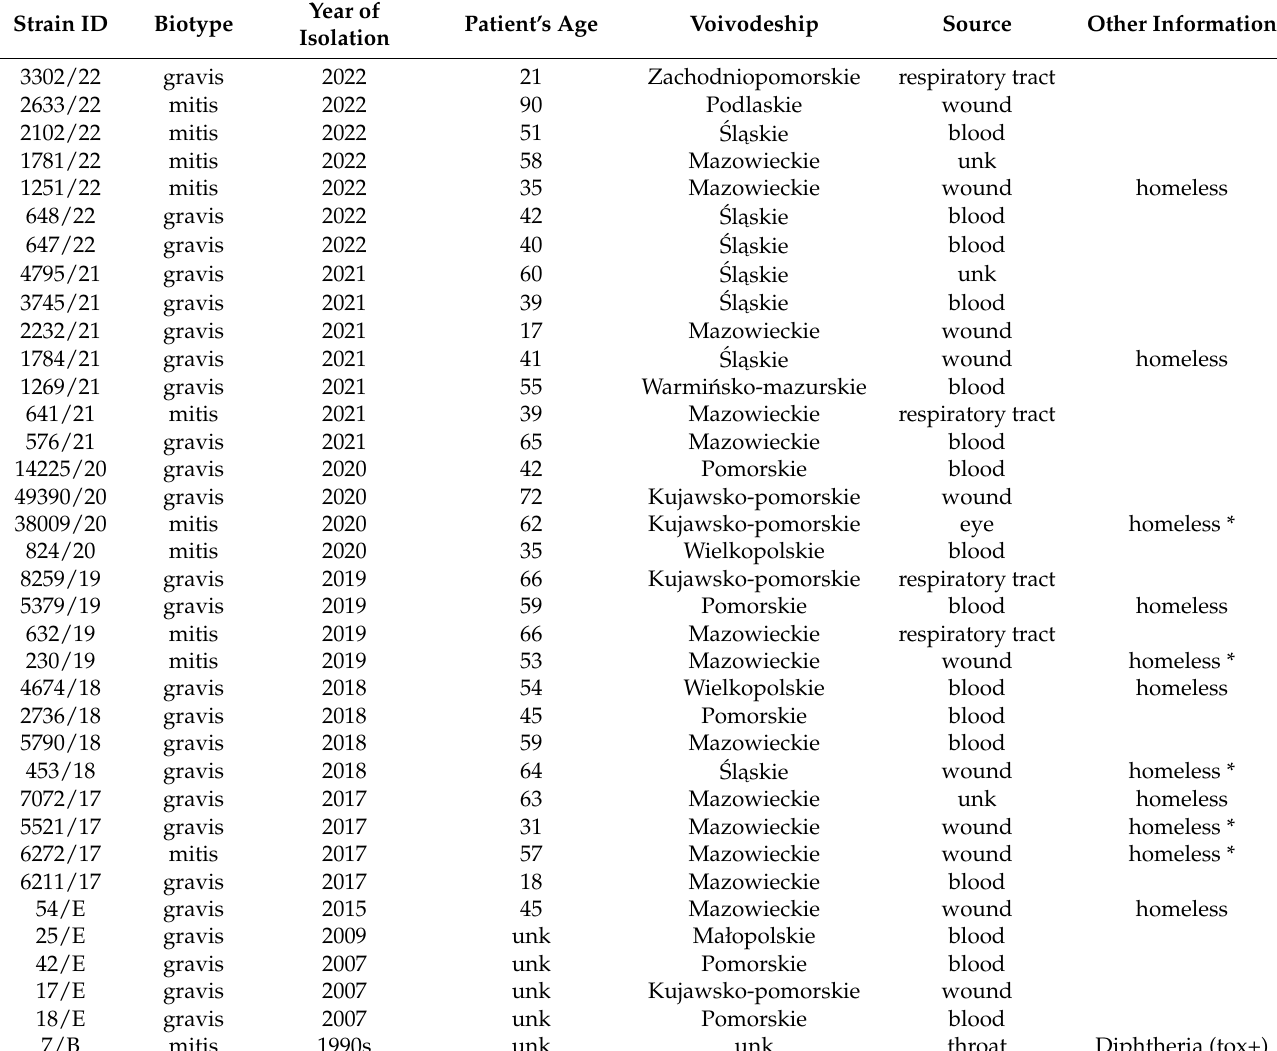
Table 1. Basic data relating to the analyzed